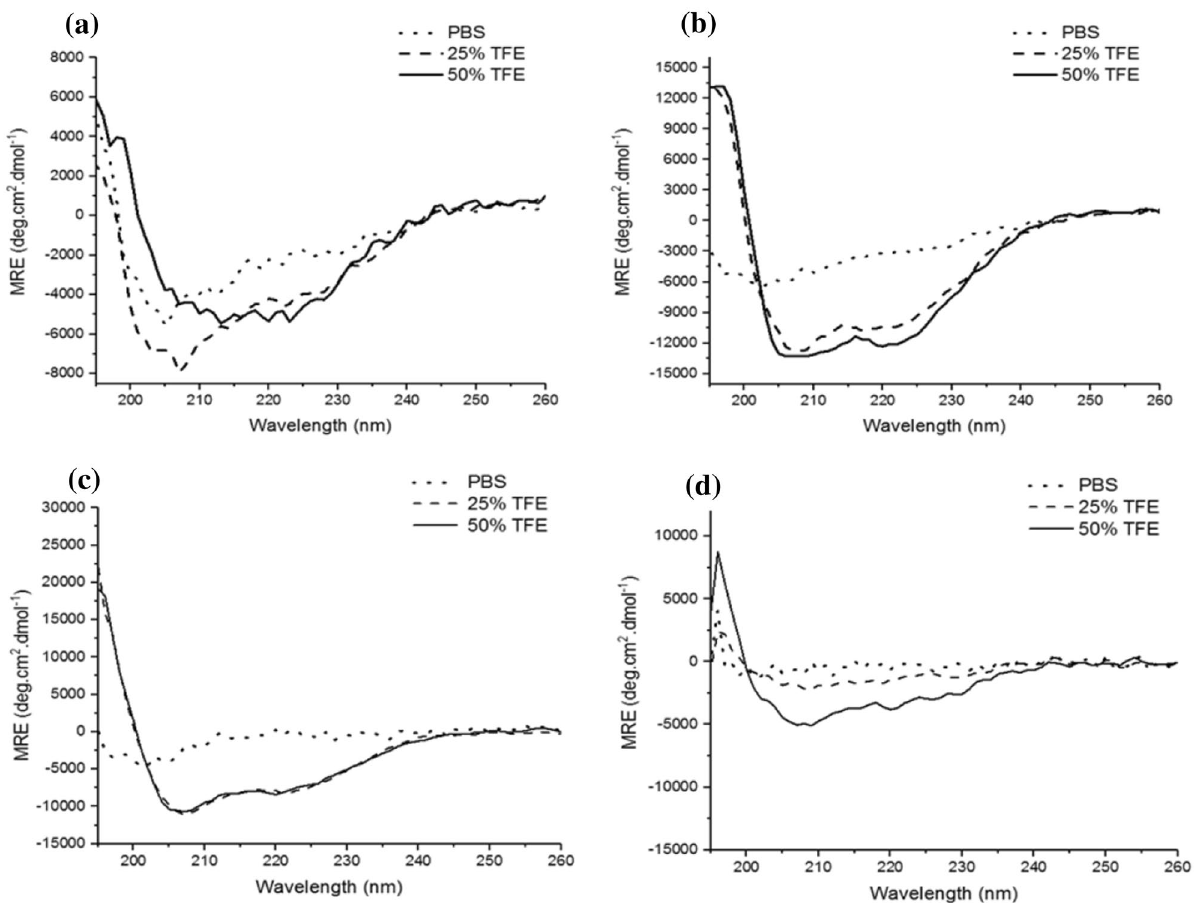
Figure 5. CD spectra exhibited by N-15 CATH-2 ( a ), DP1 ( b ), DP2 ( c ) and DP3 ( d ) in aqueous (…) and TFE- containing buffer (− 25% TFE and − 50%